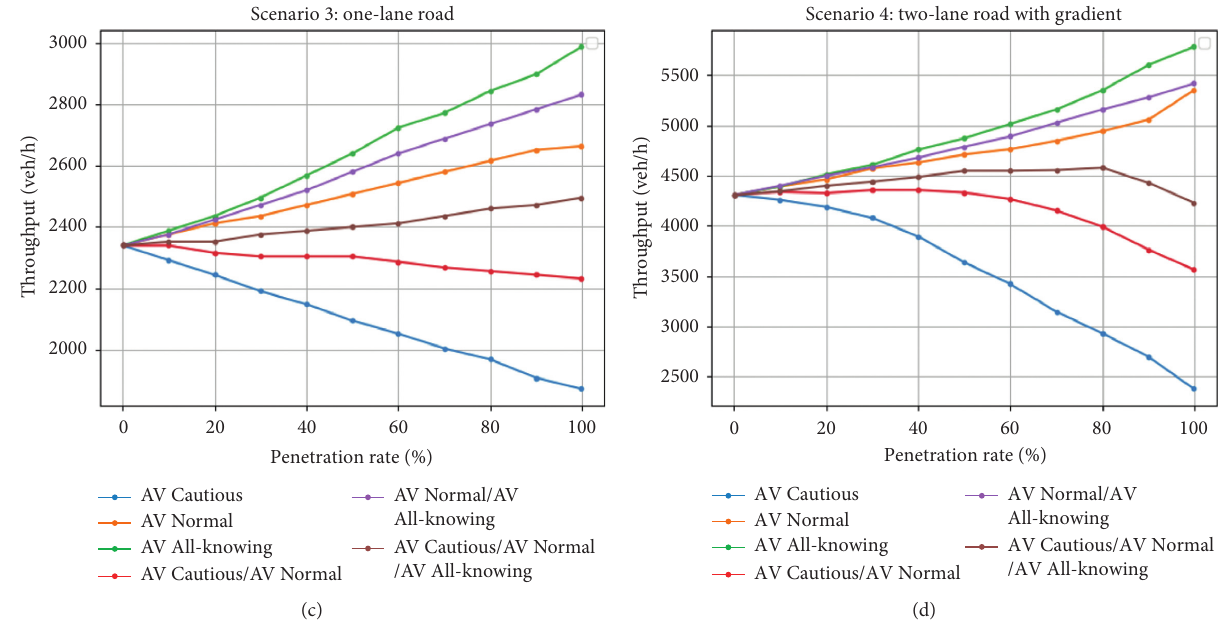
Figure 6: Results in maximum throughput depending on the AV penetration rate and driving logic mix for four different networks: gradient, simple link, on-off ramp and signal, and the AV driving logics: Cautious, Normal, and All-knowing. In the cases with a mix of driving logics, the shares of the AV logics are equal, e.g. 50/50, and